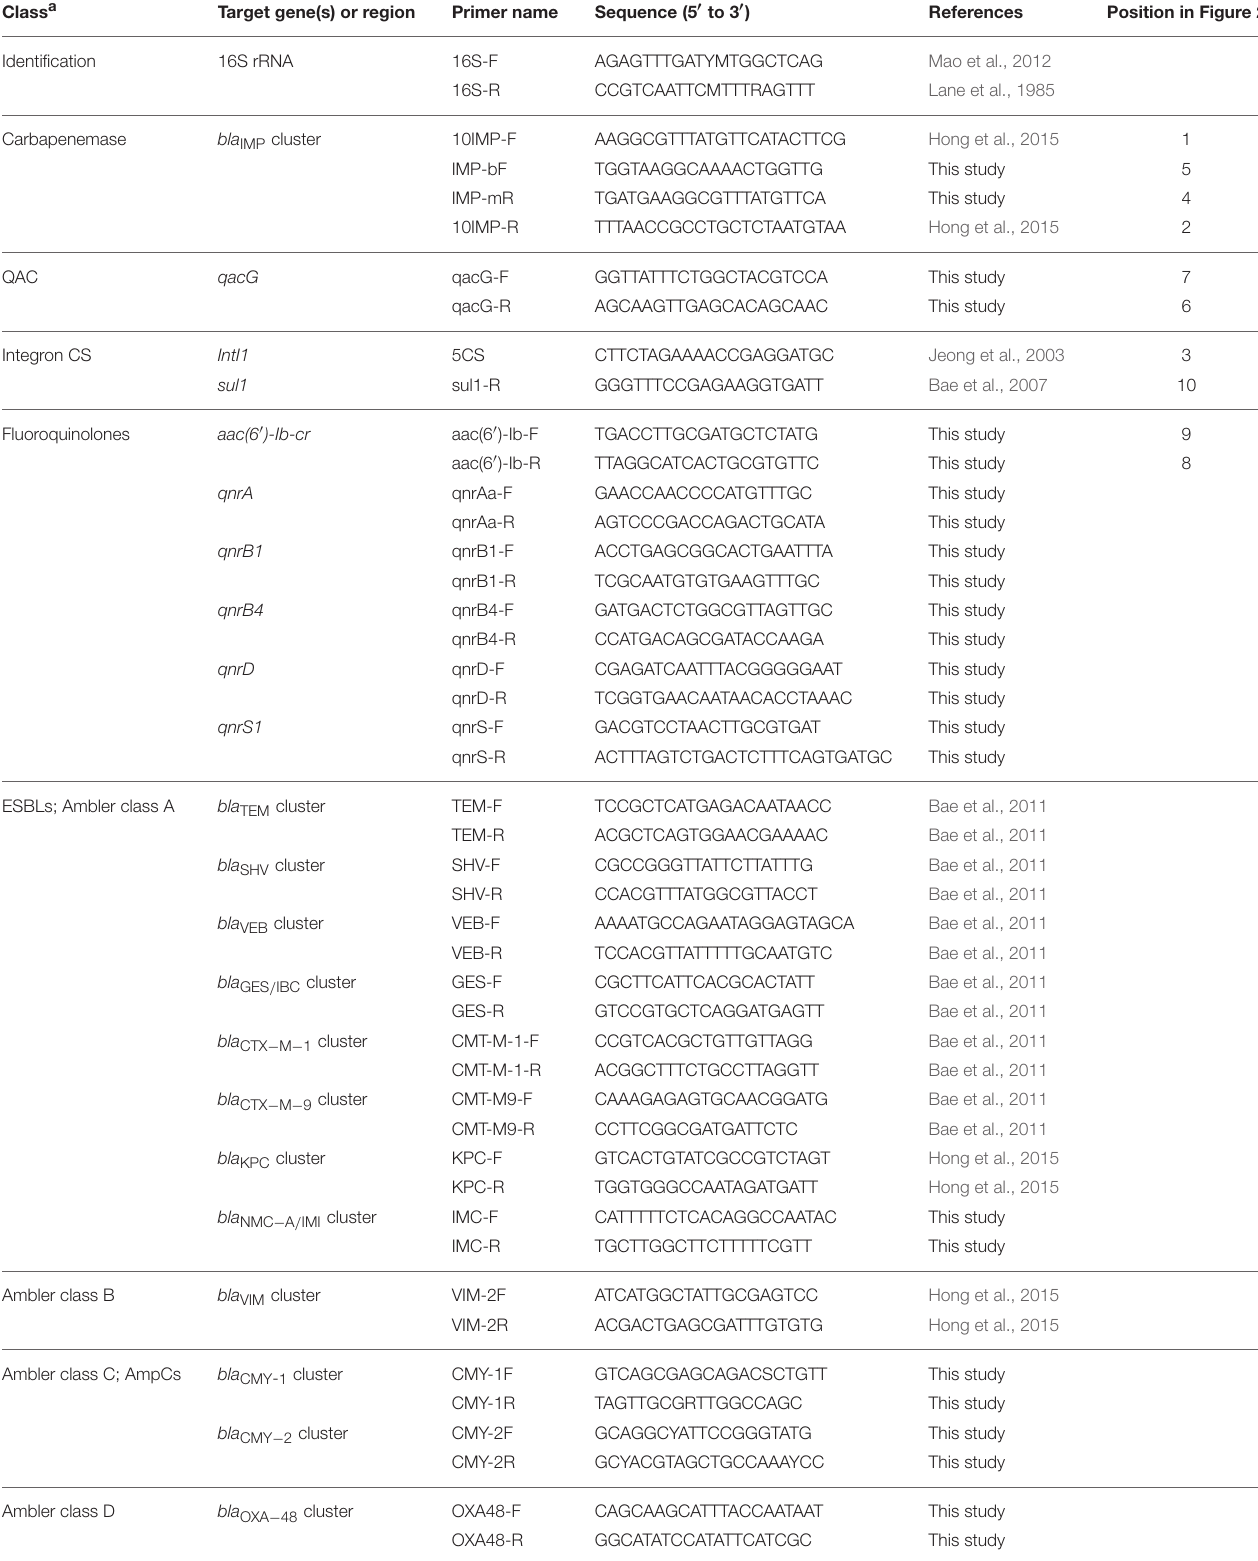
TABLE 1 | Nucleotide sequences of primers used for the identification of species, the detection of resistant genes, and genetic environments in this